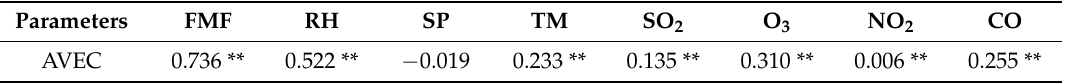
Table 2. Pearson correlation coefficient of AVEC with eight likely influence factors.